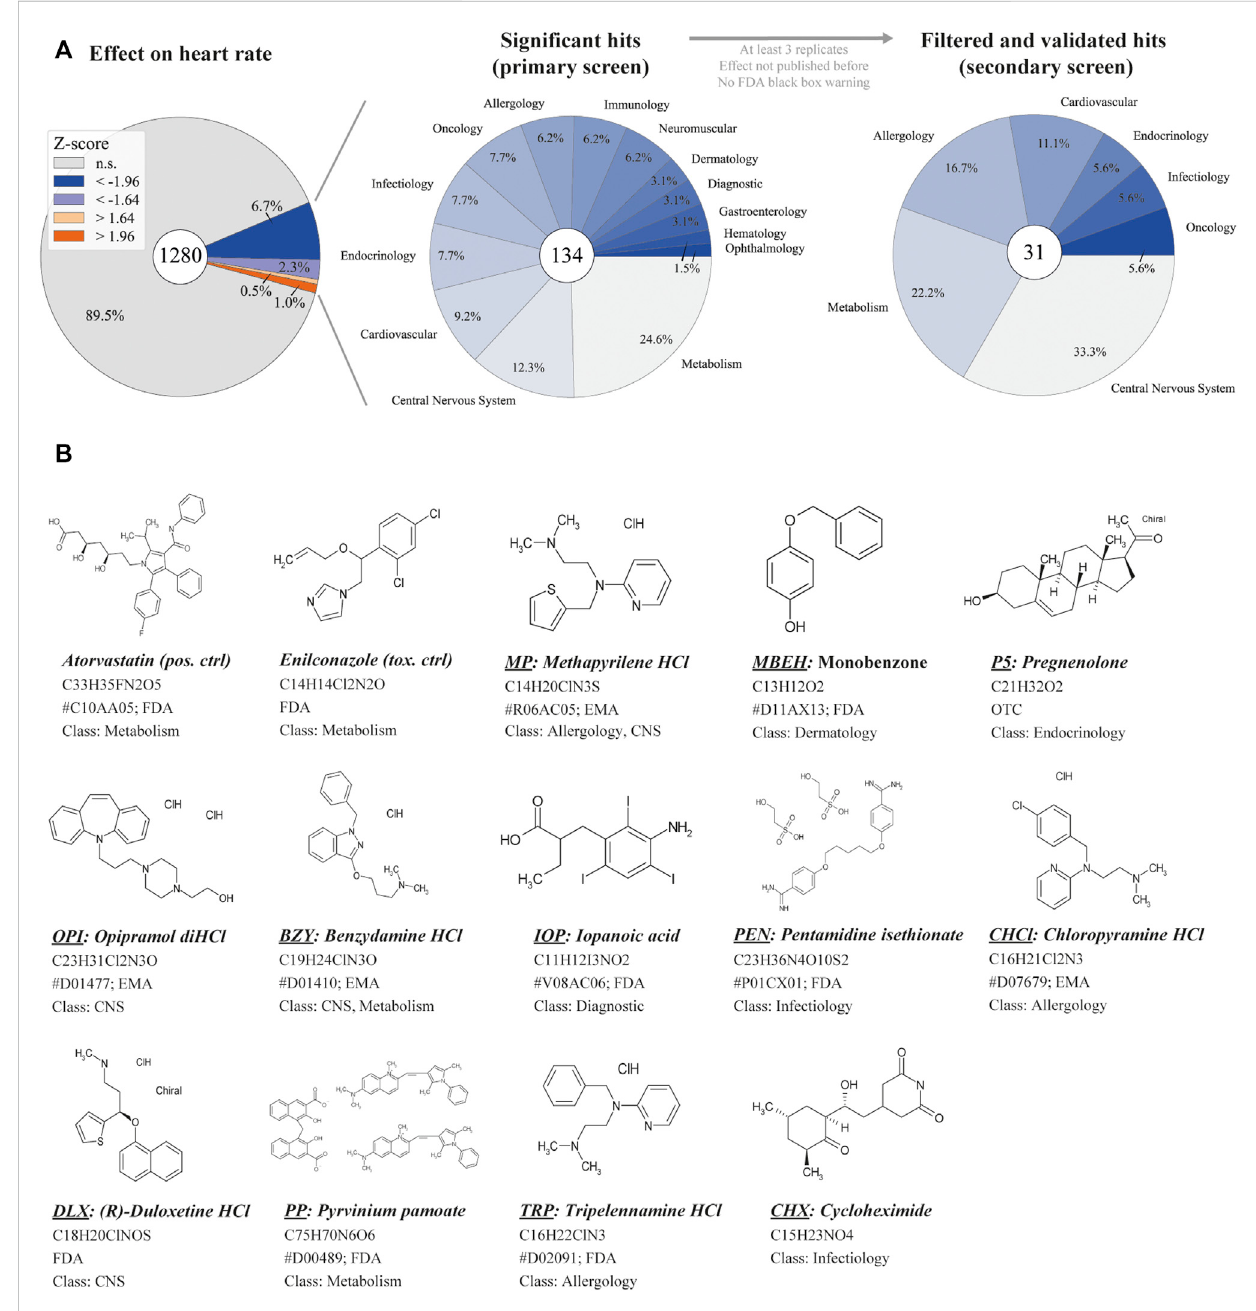
FIGURE 1 Overview of primary screening (A) High-content screening results for z-normalized heart rate data, obtained by analysis with HeartBeat software (v.2.1).Z-scoresaboveorbelow±1.96areconsideredsigni fi cantwitha95%CI.Fortheprimaryscreen,effectsizesofa90%CI(±1.64)wereconsideredto reducefalse-negativeresults.Thecenterpie-chartshowsthetherapeuticclassesofthe134hits(90%CI).Thetherapeuticclassesoftheremaining31hits after fi lter application is shown on the right. (B) The structure of selected hit compounds with cardioactive properties. Class = therapeutic class; CNS=centralnervoussystem;EMA=EuropeanMedicinesAgency;FDA=FoodandDrugAdministration;HCl=Hydrochloride;OTC=over-the-counter drug; anatomical therapeutic chemical (ATC) classi fi cation are displayed (indicated by #) if available.